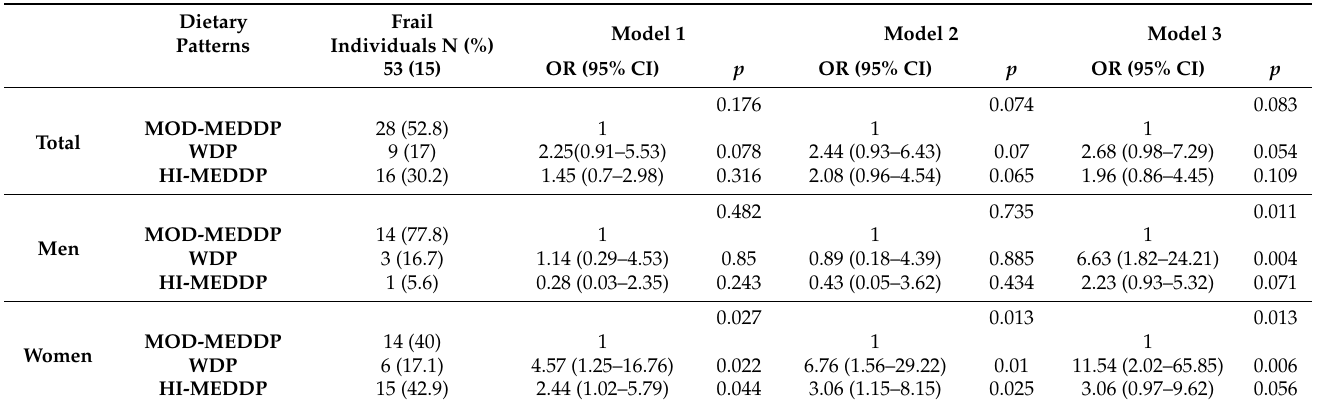
Table 6. Multivariate associations between dietary patterns and frailty prevalence. Beirut 2021, N =